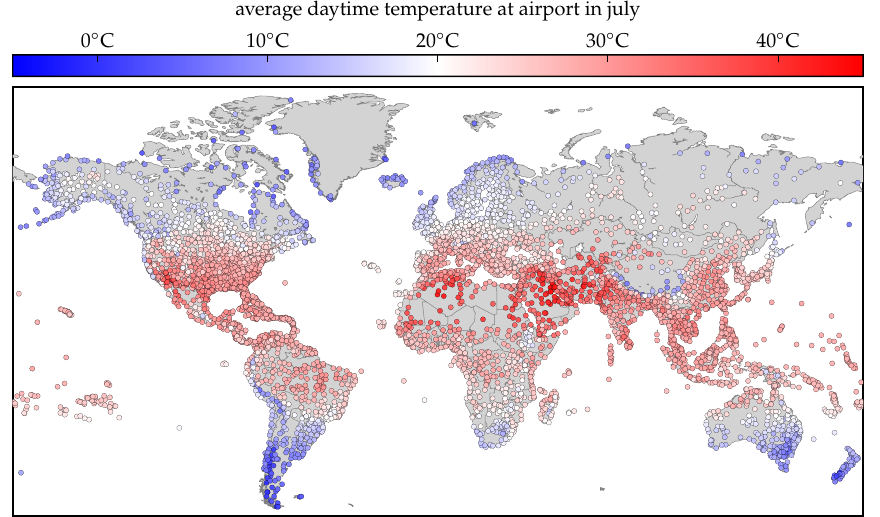
Figure 12. Available airports in LYFE with representative average daytime temperatures in